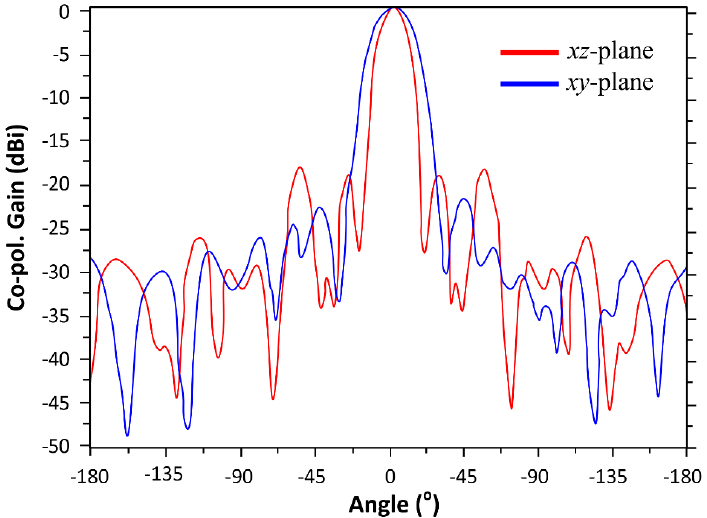
Figure 5. Normalized radiation pattern of the proposed antenna on chip at 0.45 THz in the xy -plane and xz- plane.